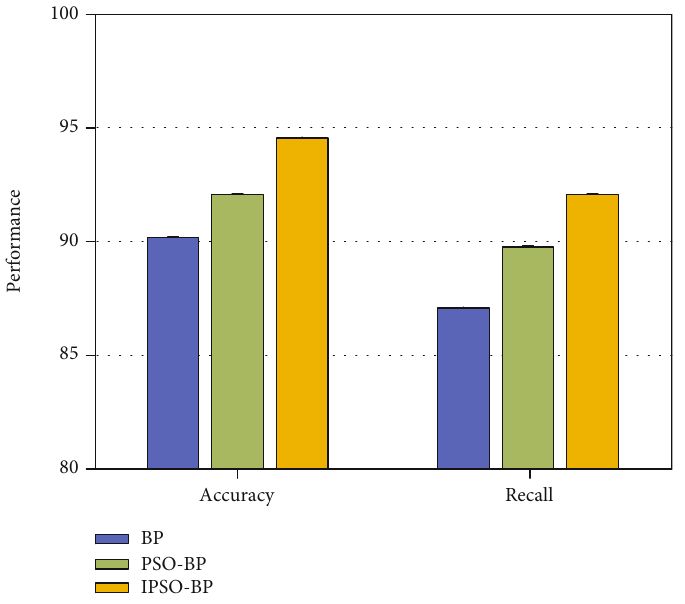
Figure 7: Comparison of BP, PSO-BP, and IPSO-BP. Table 2: Evaluation on teaching ability cultivation